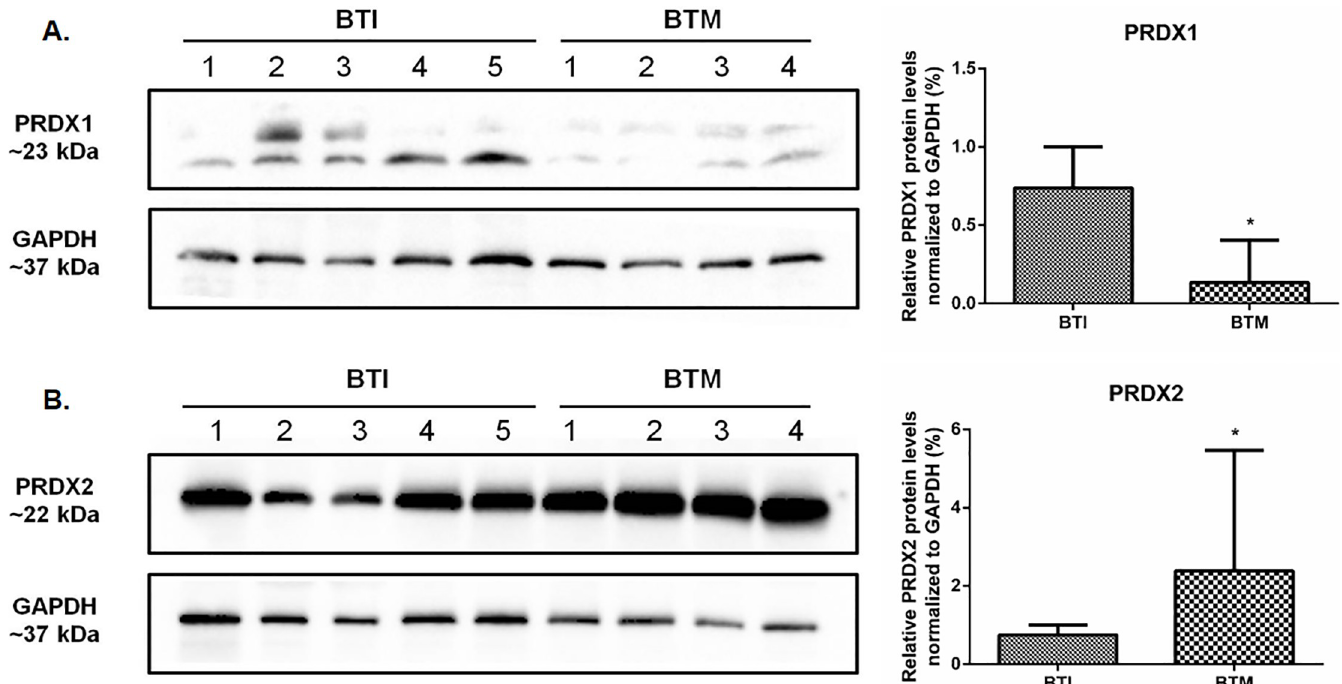
Fig 5. An opposite level of Prdx1 and Prdx2 was observed between beta thalassemia intermedia and major patients. Protein levels were measured using 50 μ g of total protein from each sample running in a 12% (w/v) reducing SDS–PAGE. The intensity of the bands was measured using GAPDH as endogenous reference. Quantitative analyzes were performed by densitometry using ImageJ Software [35]. Results are presented as mean and standard error ( ± SEM), and are representative of two independent experiments. Statistical significance: � p < 0.05.